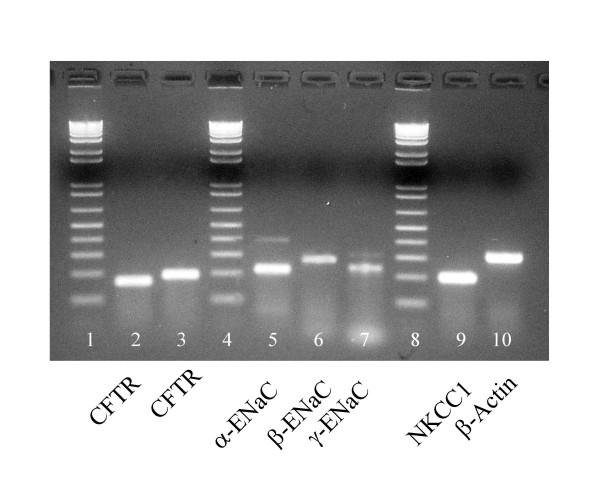
RT-PCR bands for CFTR (lanes 2 &3), α,β,γ subunits of ENaC (lanes 5,6,7 respectively), and NKCC1 (lane 9) and β-Actin (lane 10). Two independent sets of primers were used to detect CFTR. The presence of CFTR, ENaC, and NKCC1 may indicate that the epithelium has both absorptive and secretory functions. β-Actin was used as a housekeeper marker for control. Size ladders in 100 bp increments with lowest band equal to 100 bp (lanes 1,4,8).